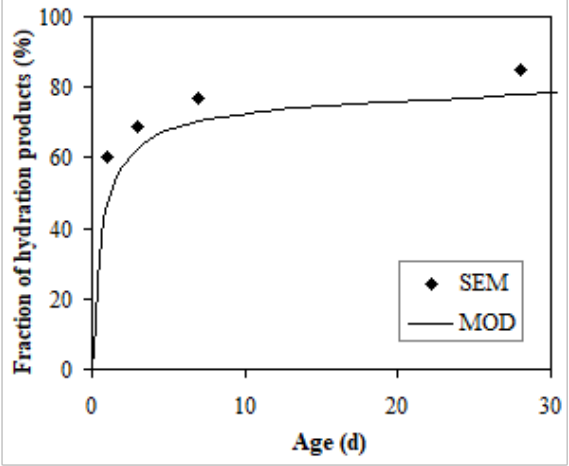
Figure 7: Fraction of hydration products of cement paste as a func- tion of hydration